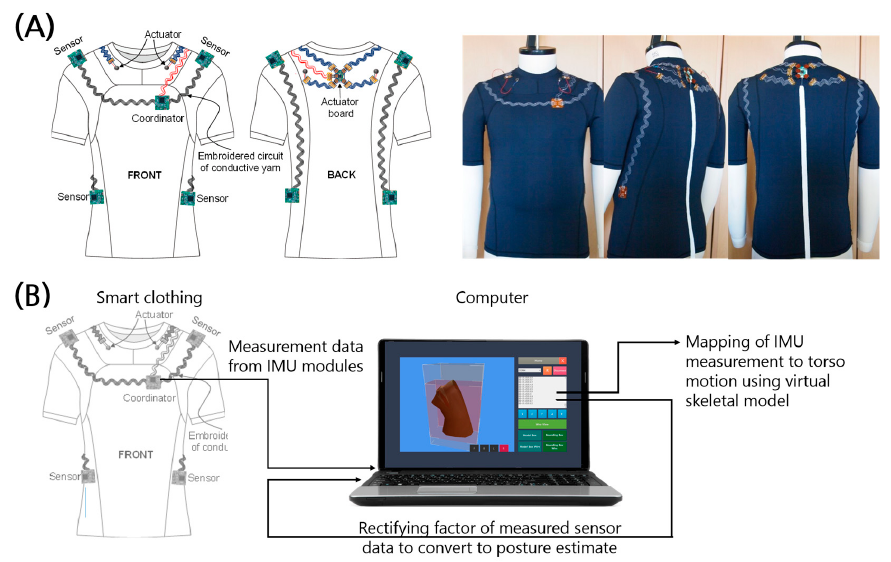
Figure 1. Schematics of IMU-integrated clothes for postural monitoring. ( A ) The sensor–actuator network, the cutting lines of the garment, and a prototype of the smart clothes. ( B ) A block diagram of the process of postural monitoring using the proposed smart clothing.